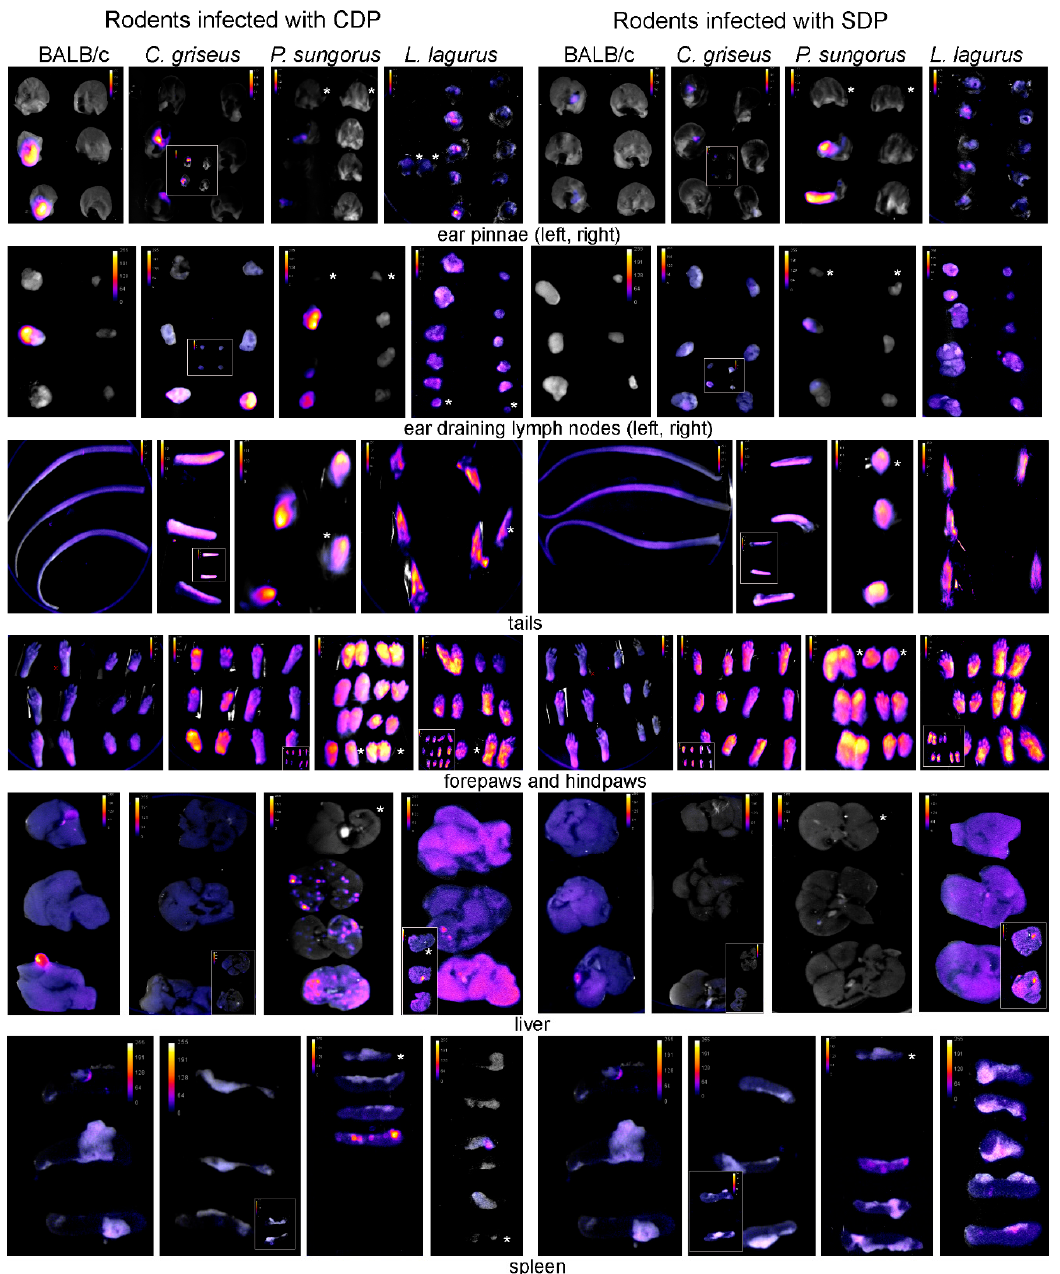
Figure A1. Tissues of infected rodents photographed with In Vivo Xtreme optical display post-mortem during the first run of the experiments.